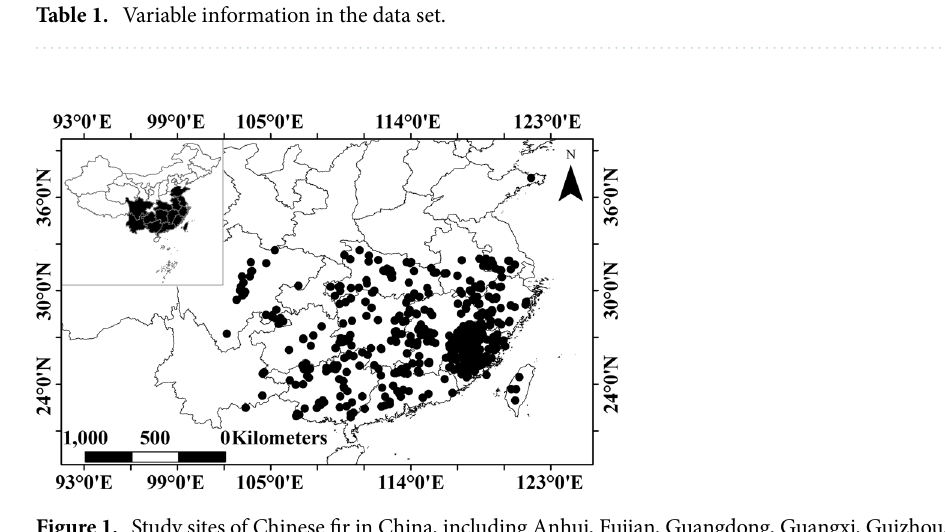
regression equations of component biomass against DBH explained more significant than 86% variability in almost all biomass data of woody tissues, including total trees, aboveground, roots, stems (with bark), barks, and explained greater than 64% variability in branches biomass (Table 4; Fig. 4). The foliage biomass equation was the poorest among biomass components (R 2 = 0.6122) (Table 4; Fig. 4).